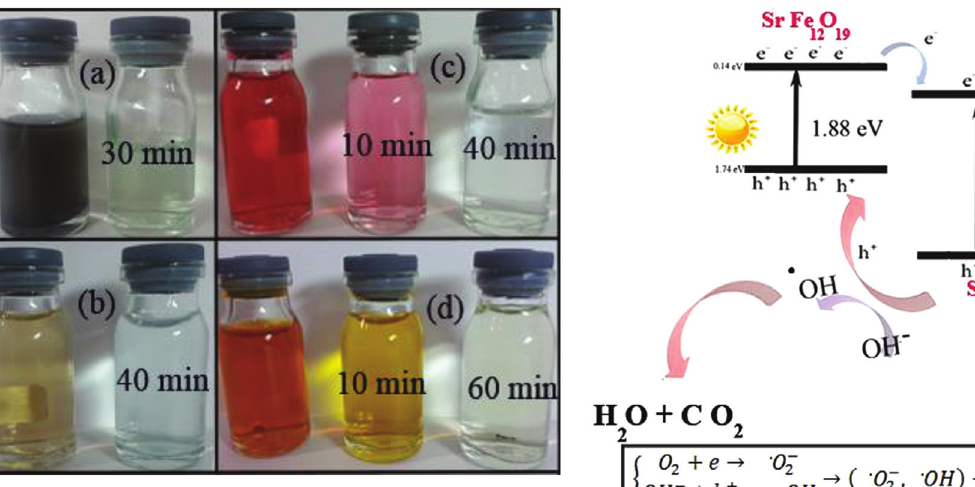
Figure 20: Photo-degradation of (a) acid black, (b) acid brown, (c) methyl red, and (d) methyl orange in the presence of nanocomposite SrFe O –SrTiO 12 19 3. SrFe O –SrTiO nanocomposite have shown a pattern 12 19 3 of pure hexaferrite strontium and perovskite strontium phase. The nanocrystalline size and the strain of the network of all particles have been calculated using the